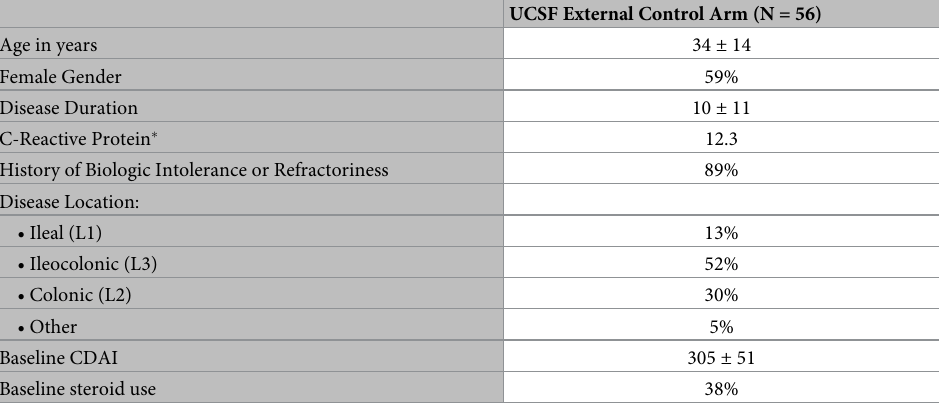
Table 6. Characterization of the study cohort. � : Reported as median, other continuous variables reported as mean ± standard deviation. Parenthetical modifiers to the disease location elements correspond to the Montreal Classi- fication of Crohn’s